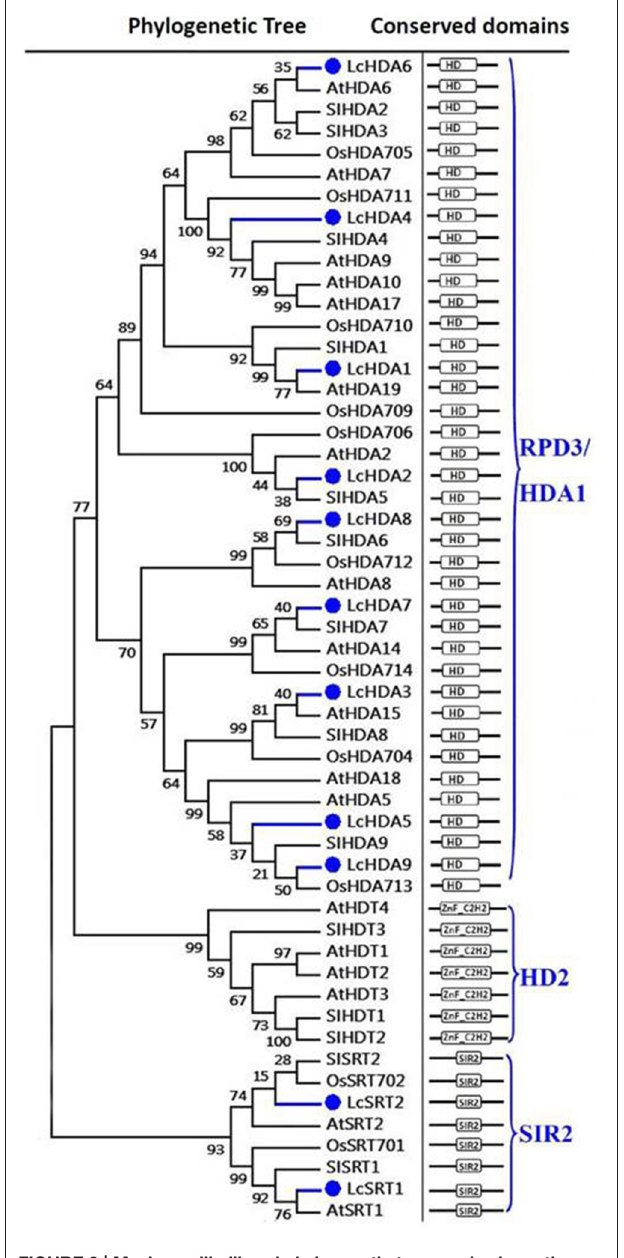
FIGURE 2 | Maximum likelihood phylogenetic trees and schematic diagrams for domain composition of HDAC proteins predicted from Litchi chinensis (Lc), Arabidopsis thaliana (At), Oryza sativa (Os), and Solanum lycopersicon (Sl). The HDAC proteins can been divided into three groups based on their conserved domain composition. The hist_deacetyl domain, HD (PF00850) is the conserved domain of RPD3/HDA1 group. C-terminal zinc finger domain in addition to the predicted HD2 domain is the typical of HD2 group. The SIR2 group is characterized by an SIR2 domain (PF02146). The phylogenetic tree was constructed based on the amino acids sequences with 1,000 bootstrapping replicates.